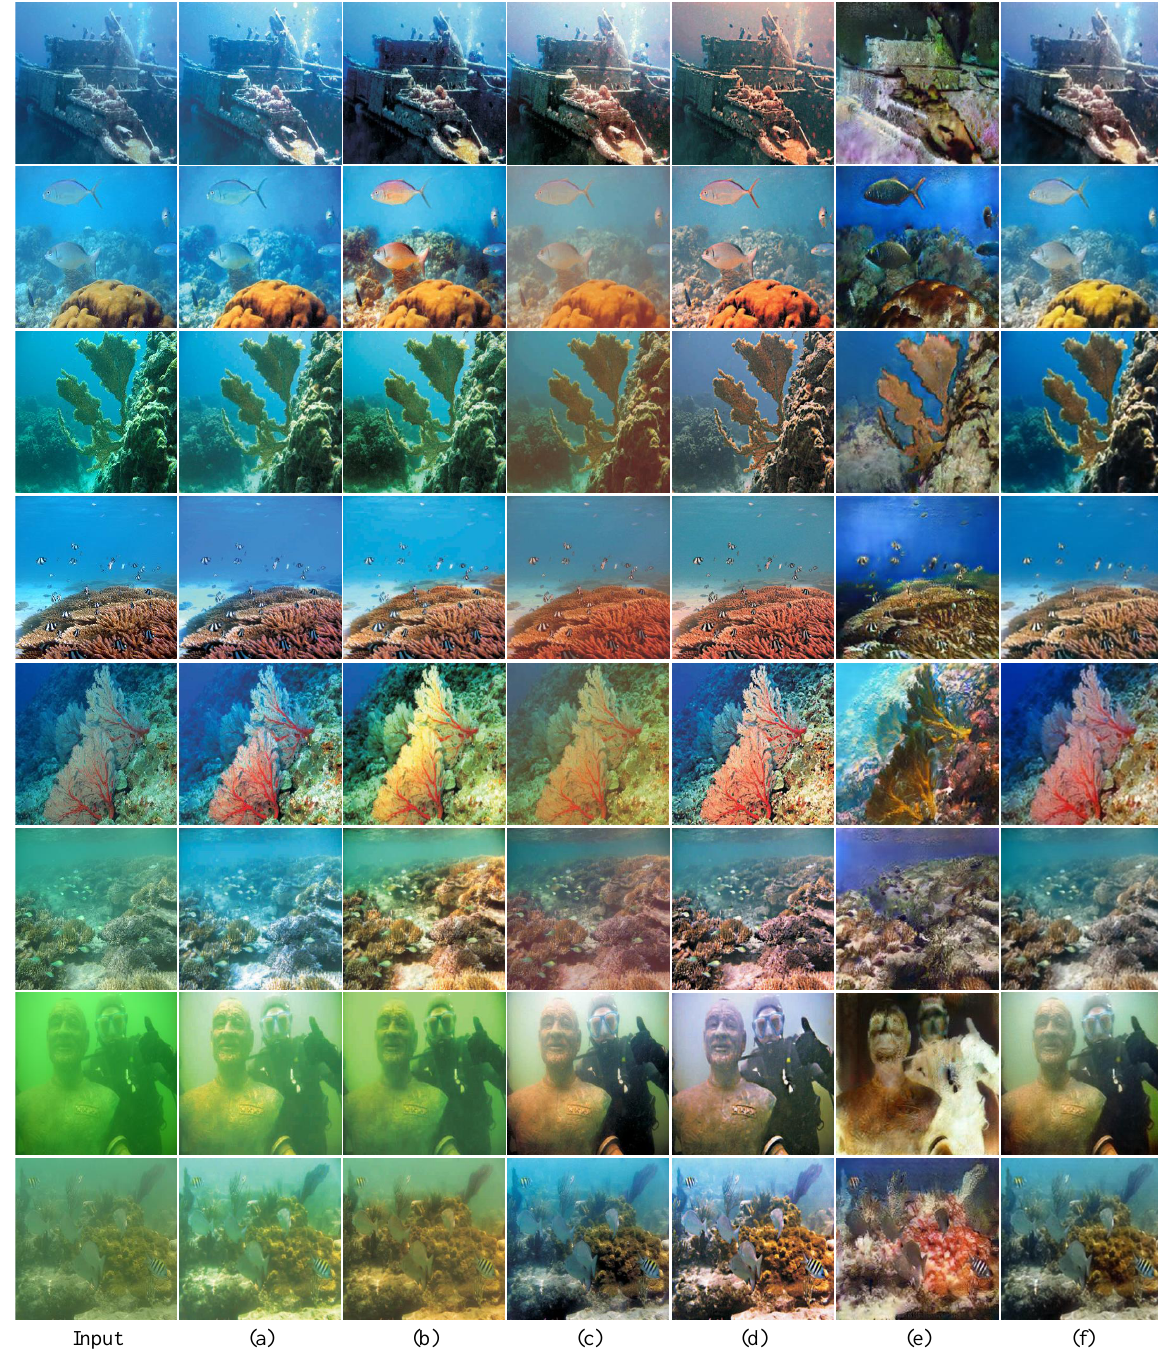
Figure 9. Underwater image enhancement results. ( a ) Ancuti and Ancuti [28]. ( b ) Galdran et al. [29]. ( c ) Emberton et al. [30]. ( d ) Ancuti et al. [23]. ( e ) Zhu et al. [16]. ( f ) Our